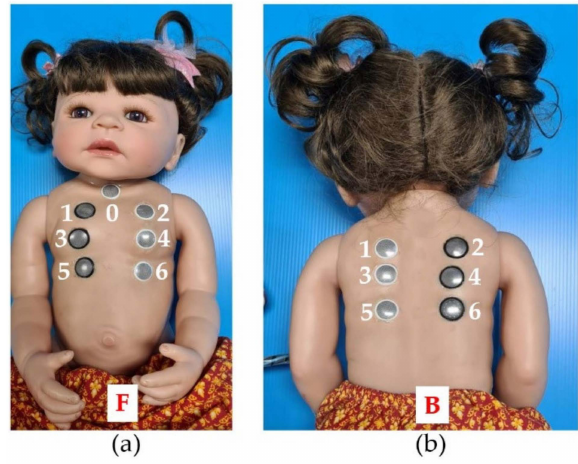
Figure 4. A child doll viewed on ( a ) the front and ( b ) the back.